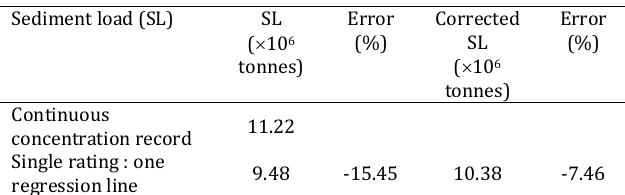
Table 1 : Rating curve estimates of measured and calculated sediment loads from the continuous record.